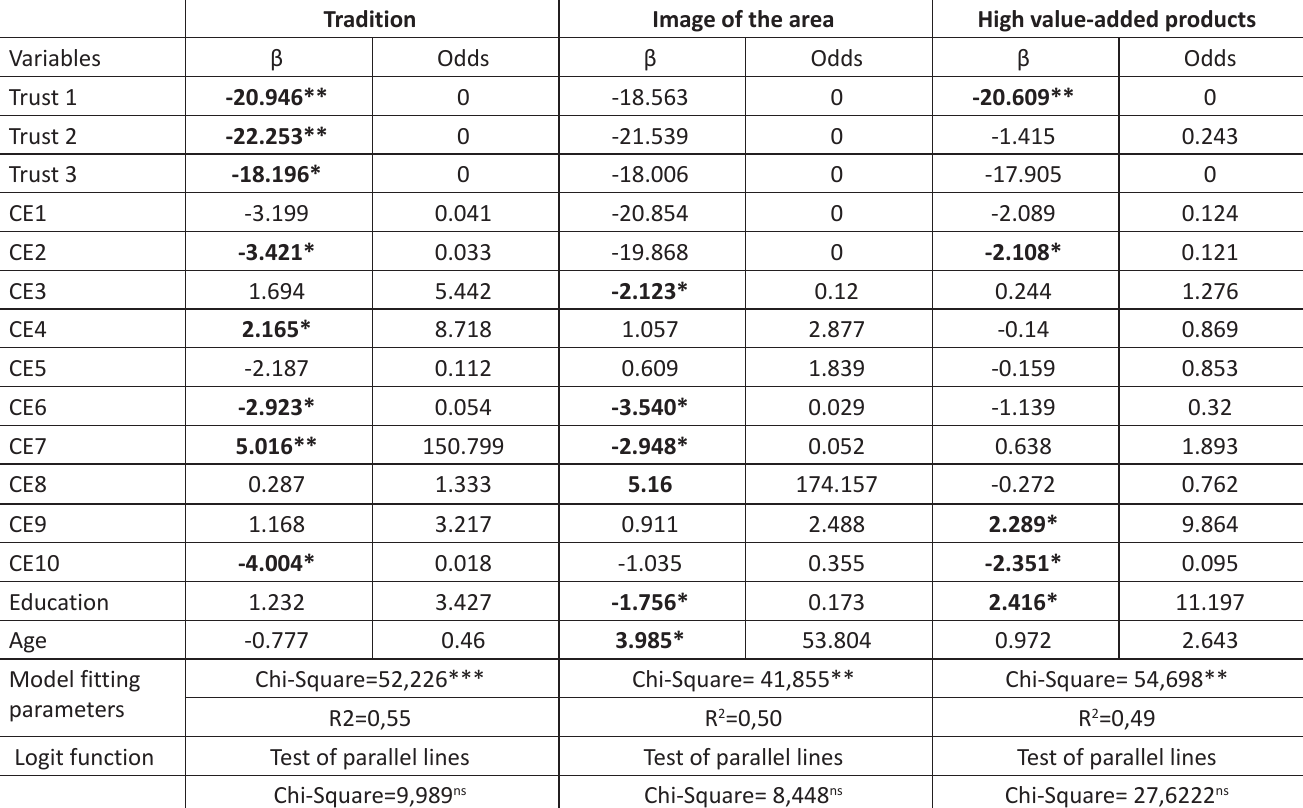
Table 4. Results of proportional odds model results linked to Cultural ES provided by the pastoral ecosystem and social capital